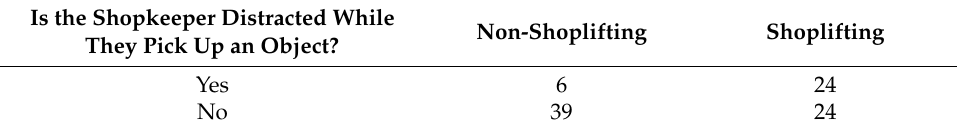
Table 15. Is the shopkeeper distracted while they pick up an object? Is the Shopkeeper Distracted While They Pick Up an